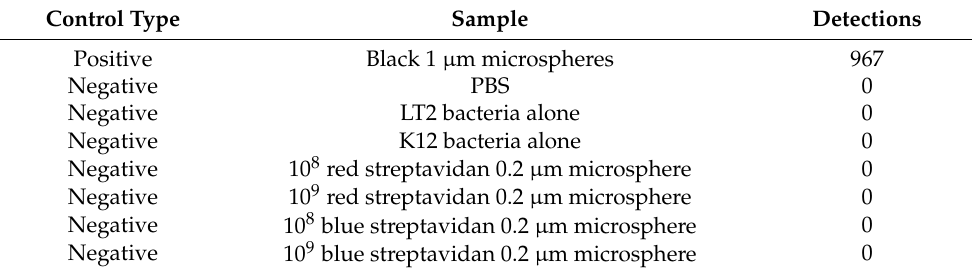
Table 1. Control experiments demonstrating positive signals from black microspheres while obtaining no signals from PBS, target and non-target bacteria, and red and blue microspheres.